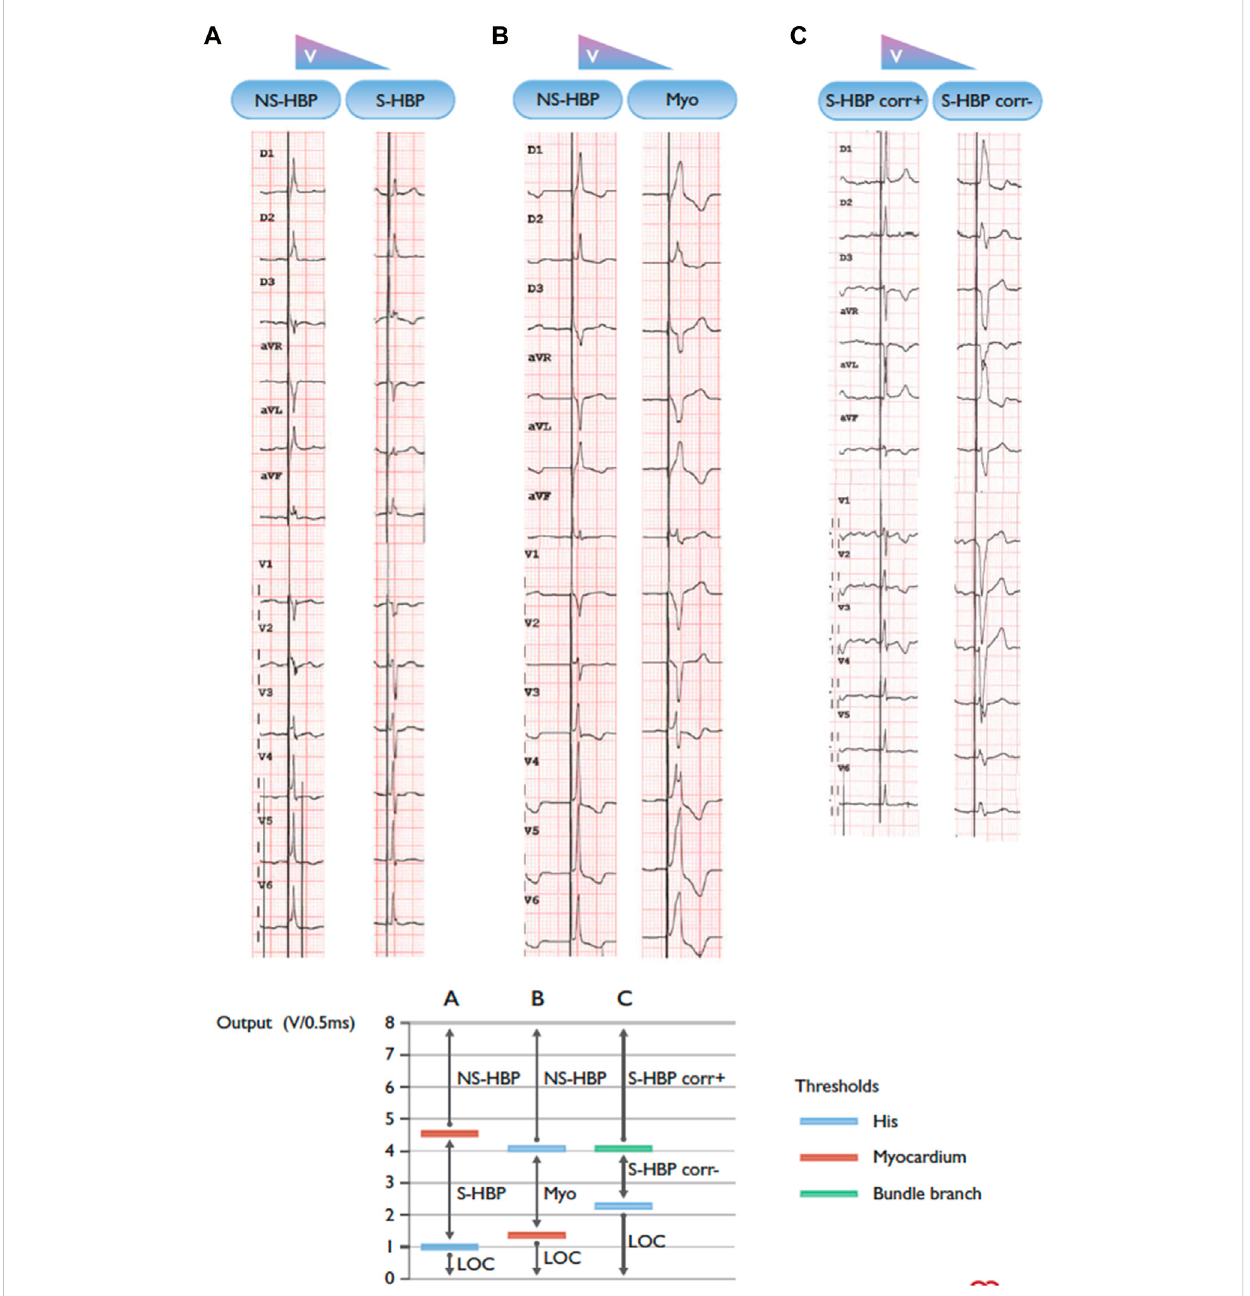
FIGURE 2 Threepatients withdifferenttypes oftransitions inQRSmorphology withHisbundle pacing and decrementing pacing output.BBB=bundle branch block; Corr± = with/without correction of bundle branch block; LBBB = left bundle branch block; LOC = loss of capture; Myo = myocardium; NSHBP = non-selective His bundle pacing; S-HBP = selective His bundle pacing. (A) Non-selective to selectiveHis capture. Note the presence of a “ pseudo-delta ” wavewithnon-selectivecaptureandanisoelectricintervalafterthepacingspikewithselectivecapture. (B) Non-selectiveHiscapturetomyocardial capture only. (C) Selective His capture with correction of BBB to selective His capture with LBBB. Note: the graph on the right of the panel shows a schematic representation of the different thresholds in the three instances. Adapted from Glikson et al. (2021) with permission.